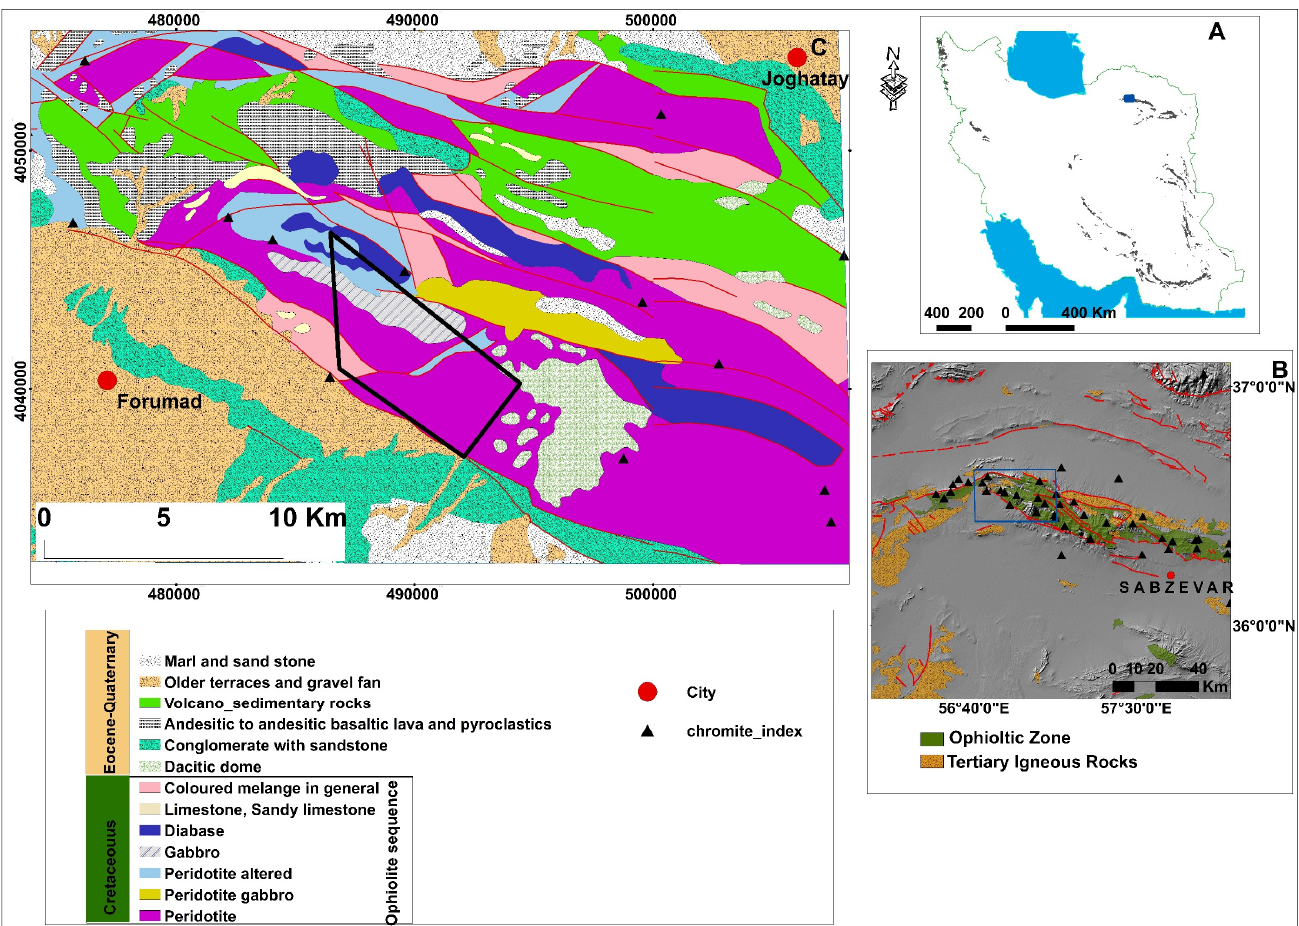
Figure 1. ( A ) The location of the study area (blue rectangle) in the sketch map of Iran, also shows the distribution of ophiolite zones (black polygons) across the country. ( B ) The study area (blue rectangle) with regard to Sabzevar Ophiolite (SO) zone and tertiary igneous rocks. The black triangles (also labeled as chromite_index in part C of Figure 1) show the known chromite occurrences and deposits within the study area (see Appendix A for details). ( C ) The simplified (except ophiolite sequence units) geological map of the study area (Appendix A). The black rectangle is the main surveying area where UAV and geological mapping were performed.